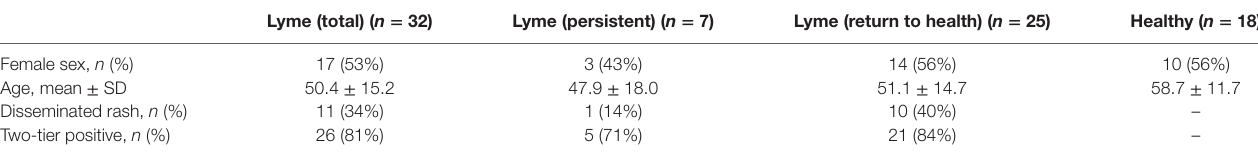
TaBle 1 | Bb infected and healthy control subject